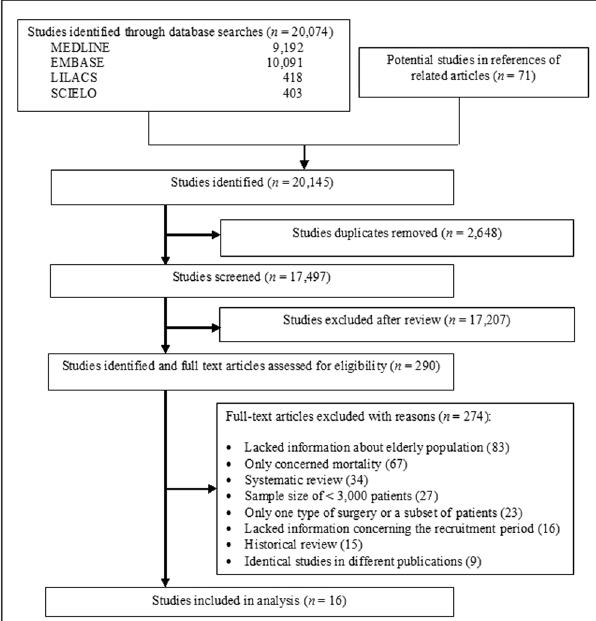
Figure 1. Flowchart of the process used to identify studies for